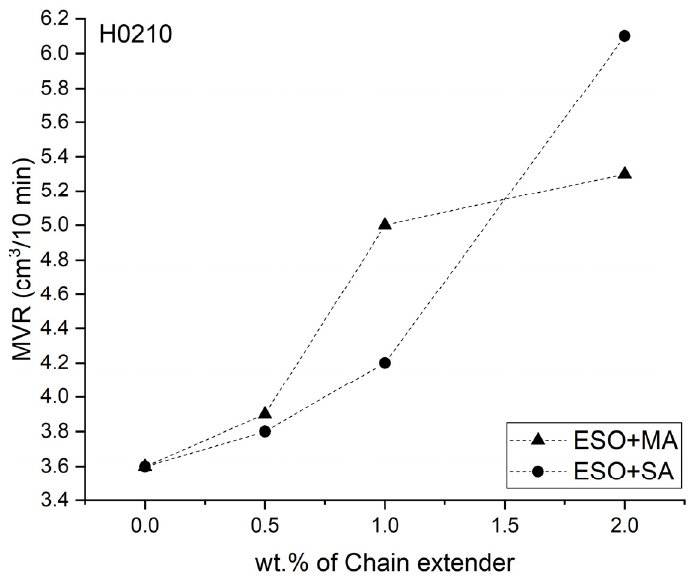
Figure 7. MVR trend for biocomposites based on H0210 HSP.